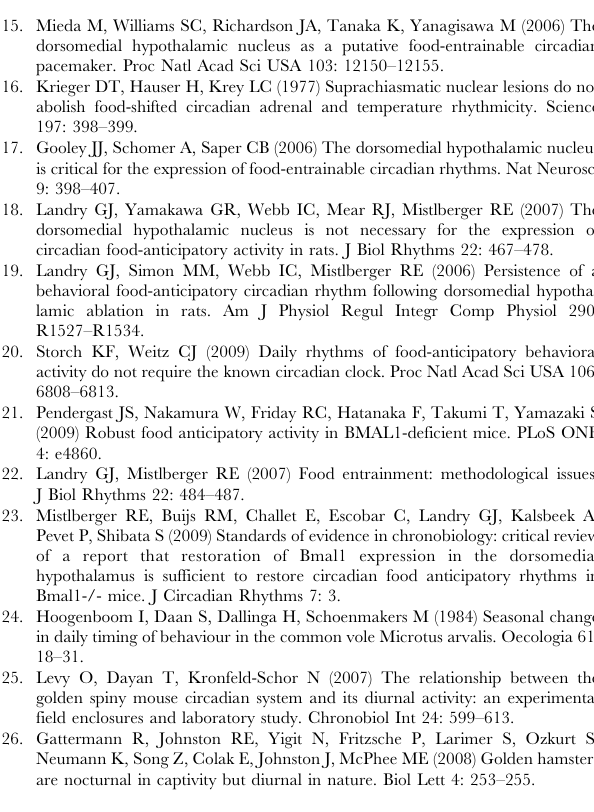
Fig. 1&2: control n = 12, experimental n= 12; Fig. 3: n= 12. Running wheel activity was recorded continuously and stored in 2- min bins. Onsets and offsets of activity (Fig. 1E) were determined over 8 days just before the switch to DD or right after the switch to DD following the procedure previously described [27]. In the work for food protocol, a small 45 mg food pellet (F0165; Bio-Serv, Frenchtown NJ, USA) was delivered in the mouse cage after a set number of wheel revolutions using computer controlled pellet dispensers (Med Associates Inc., St.Albans VT, USA). During the ‘work for food’ protocol, mice started on a high reward schedule (100 revolutions/pellet). This generated essentially an ad libitum food condition, because excess pellets were observed in each individual kept under these conditions. During the reward reduction phases of the experiment, workload was increased daily by an extra 10–20 revolutions per pellet up to 200 revolutions per pellet (medium reward schedule) or 300–400 revolutions per pellet (low reward schedule). Throughout the experiment body mass was closely monitored at least every 3 rd day at different times of day and high workload levels were individually titrated to keep the mice above 18 grams and 75% of their initial body mass. Body temperature was measured by customised temperature loggers (Thermochron iButton, DS1922L, Maxim Integrated Products Inc., Sunnyvale CA, USA) implanted in the abdominal cavity of the mice and set to a sampling rate of once every 20 minutes (see Text S1 – Detailed Methods).